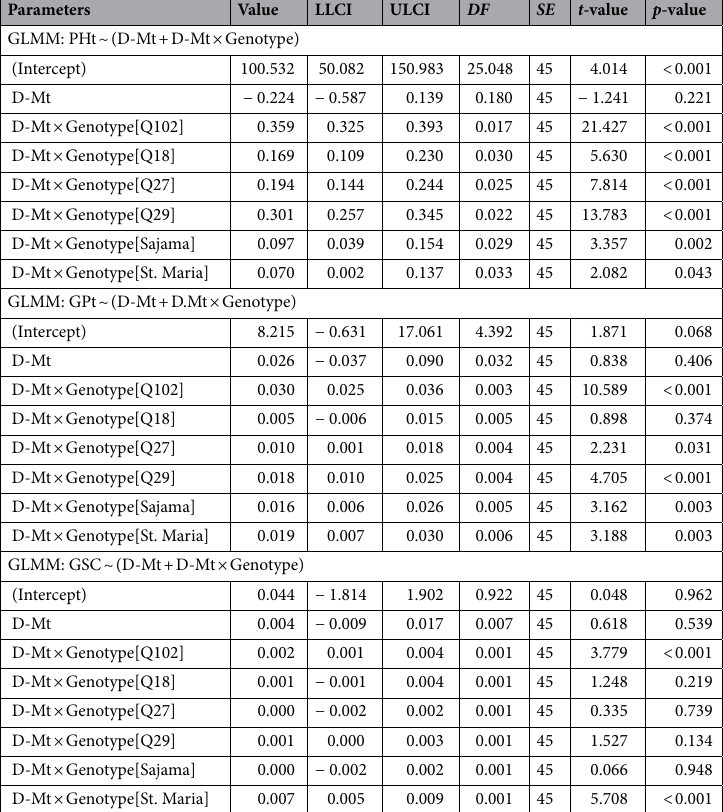
Table 5. Parameters of generalized linear mixed-effects models testing the variation of plant height (PHt), grain proteins (GPt) and grain saponin content (GSC) following the plant maturation (D-Mt) of seven quinoa genotypes cultivated in open field under hot-arid conditions of the Sahara Desert. DF : degrees of freedom, LLCI and ULCI: lower and upper limit of the confidence interval,